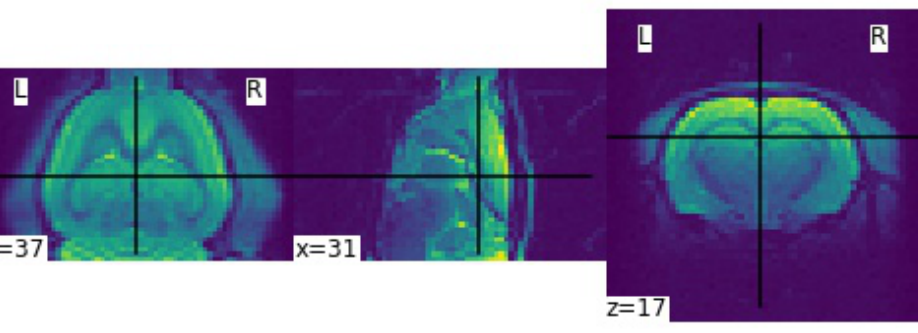
Figure 2. Example of one Magnetic Resonance Imaging (MRI) scan with resolution of 64 × 64 × 40 from the Sigma rat brain dataset displayed in all three planes—coronal, sagittal and axial planes,